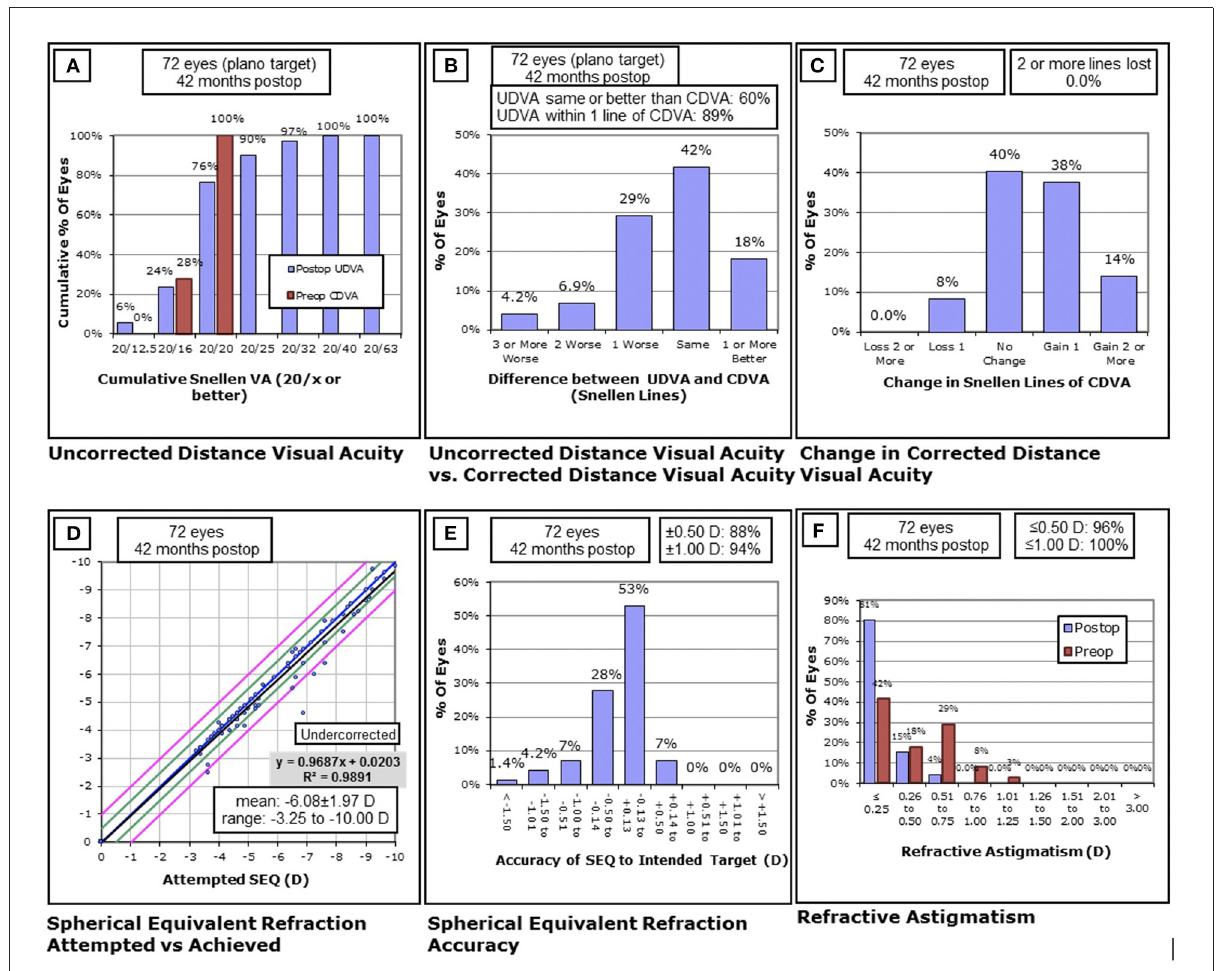
FIGURE1 Clinical outcomes of 72 eyes with high and moderate myopia at the last follow-up after SMILE. (A) The postoperative uncorrected distance visual acuity (UDVA) vs. preoperative corrected distance visual acuity (CDVA); (B) the difference between preoperative CDVA and postoperative UDVA; (C) the change in CDVA; (D) the attempted vs. the achieved spherical equivalent refraction change; (E) the distribution of postoperative spherical equivalent refraction accuracy; (F) the postoperative residual astigmatism vs. preoperative astigmatism. D, diopters; Postop, postoperative; Preop, preoperative; mo,